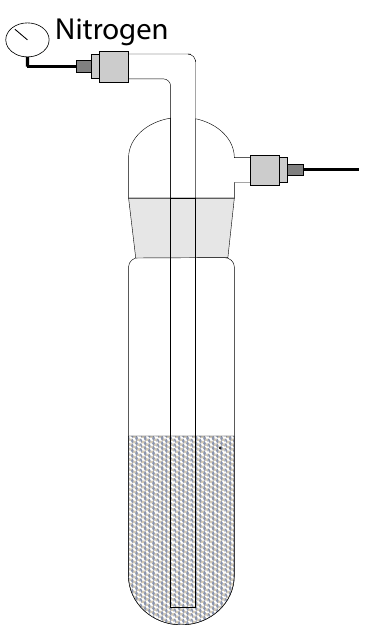
Figure 2. A diagram of the apparatus used for preparing the Schütze reagent. It is mounted in an oven and flushed with a slow continu- ous flow of nitrogen gas in order to dehydrate the iodine pentoxide- coated silica gel efficiently, while the temperature distribution is ho-